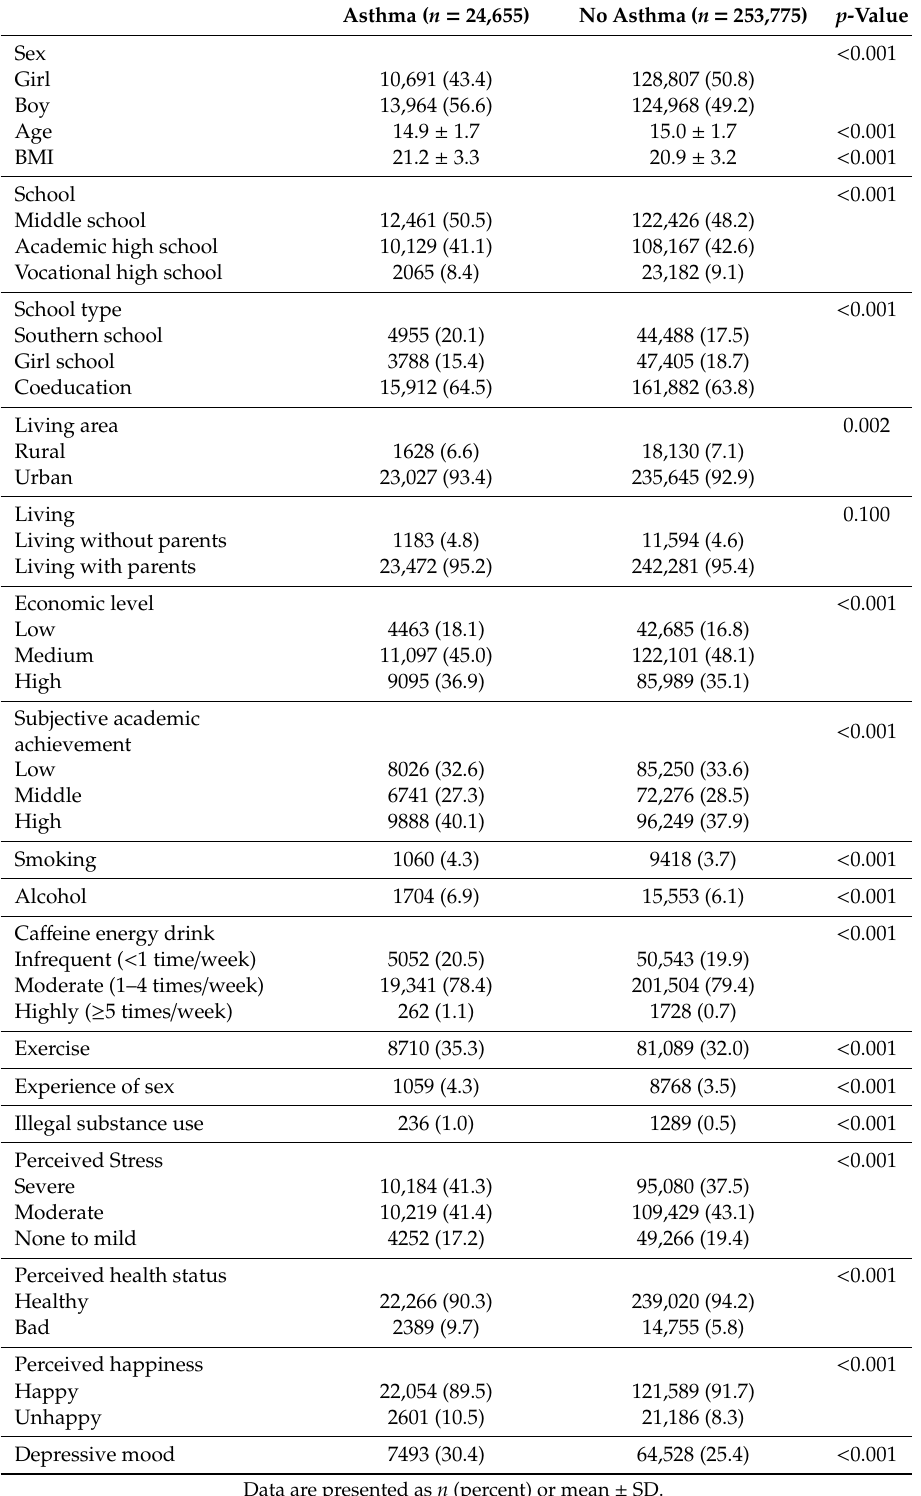
Table 1. General characteristics of participating